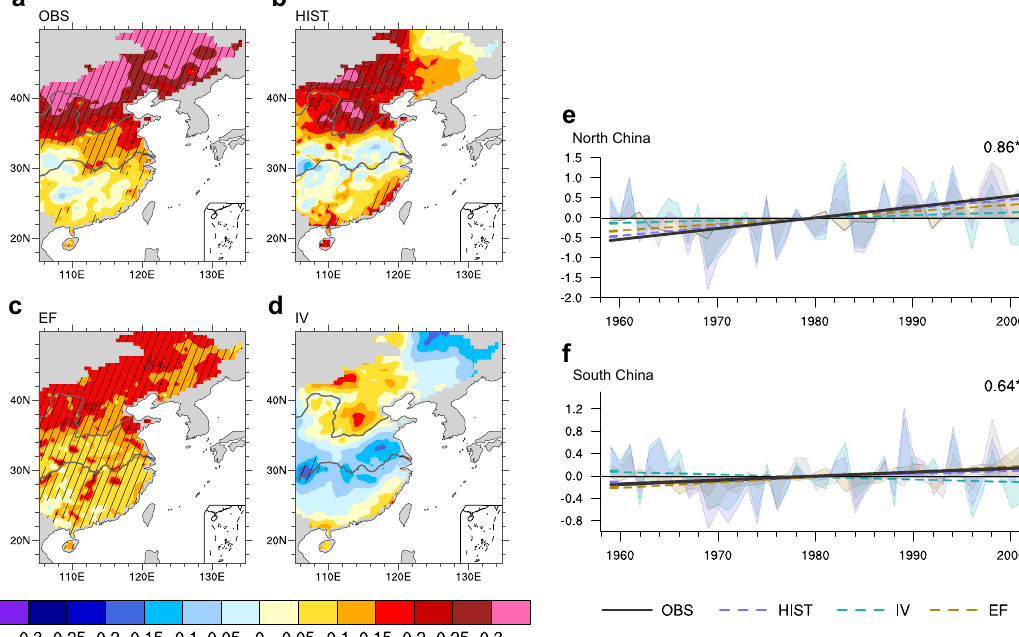
Fig. 3 Linear trends in the annual mean temperature at 2 m. Linear trends (°C decade – 1 ) in a Observational data (CRU and UDEL), b the WRF historical (HIST) run, c the response to external forcing (EF), and d the WRF internal variability (IV) run during the time period 1959 – 2001. The hatched areas and asterisks denote a signi fi cance level of 0.05. The two gray lines on the map show the location of the Yellow River in North China and the Yangtze River in central China. The time series of regional mean temperature anomalies (shaded areas; °C) and the linear trends (lines; °C yr – 1 ) over e North China (35° – 43°N, 110° – 122°E) and f South China (24° – 32°N, 110° – 122°E). The correlation coef fi cients between HIST and observation are shown in the upper right corner of each